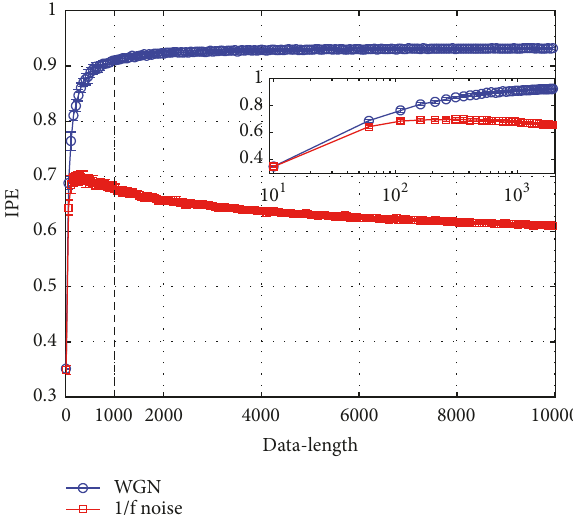
Figure 2: Error bar plot of IPE over a varying embedding dimen- sion.